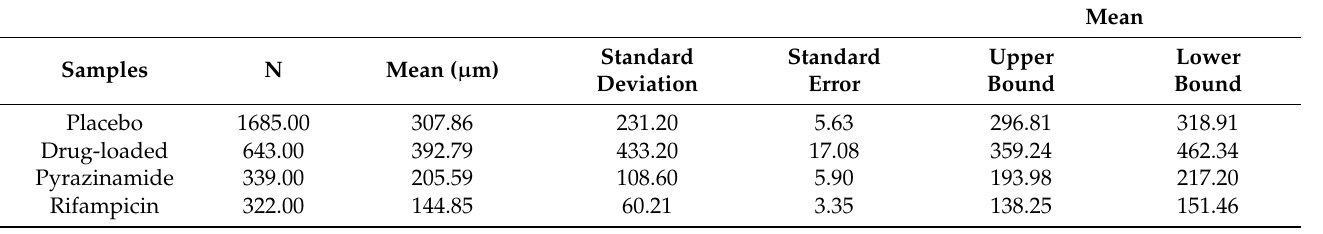
Table 7. Summary of analysis of variance results for quadratic model of particle size for reconstitutable powder formulation.